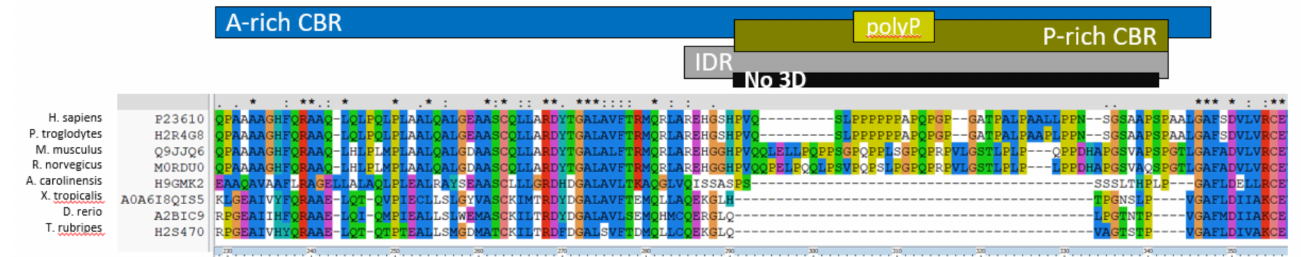
Figure 4. A-rich region and bordering polyP in HAP40. The polyP (alignment coordinates 305–314) overlaps a larger P-rich compositionally biased region (CBR) (291–342), which almost corresponds to a predicted IDR (285–342). These features are within the N -terminal of an A-rich CBR that extends well into the ordered part of HAP40 (111–347). The IDR prediction corresponds well to a fragment missing in 3D (indicated also in Figure